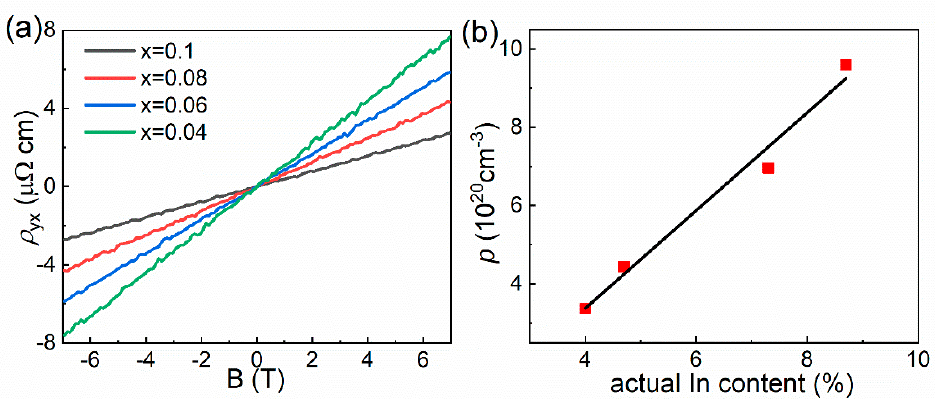
Figure 4. ( a ) Magnetic field dependence of Hall resistivity, ρ yx (B), for all indium doped crystals measured at 10 K. ( b ) Hole density as a function of the actual indium content.